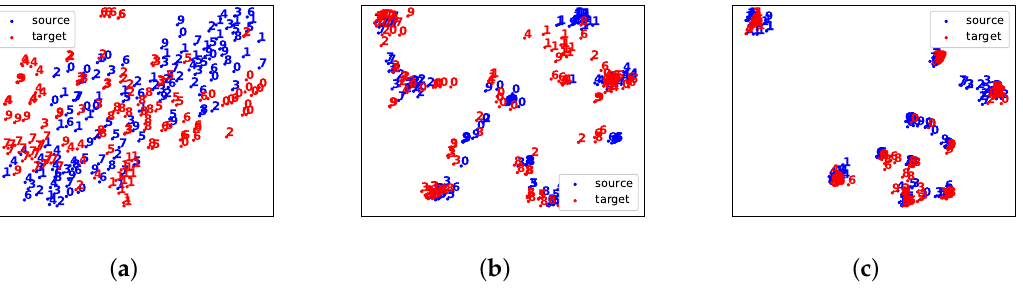
Figure 5. Visualization of images and feature distributions of source and target domains using T-SNE [43], the blue and red digits represent source SVHN dataset and target MNIST dataset respectively. ( a ) original images distributions of both domains; ( b ) feature distributions of both domains generated by the source agent S ; ( c ) feature distribution of both domains generated the proposed adversarial hard attention adaptation model.